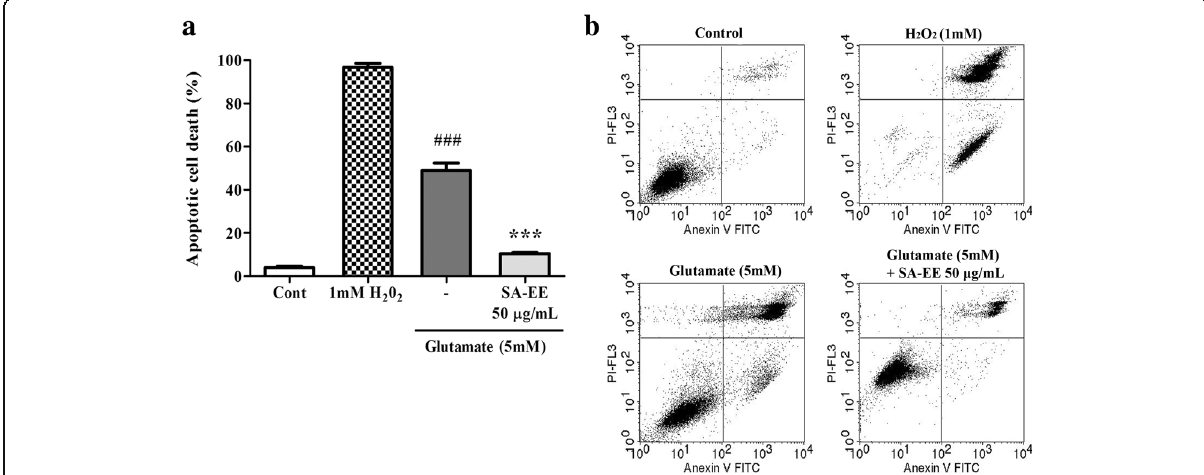
Fig. 4 Quantitative flow cytometric analysis of apoptotic cells in HT22 cells. HT22 cells were exposed to 5 mM glutamate alone or glutamate in combination with 50 μ g/mL SA-EE for 18 h before staining with FITC-conjugated annexin V and PI. H 2 O 2 -treated cells were used as a positive control. Percentages of apoptotic cells were detected using flow cytometric analysis of annexin V-positive/PI – negative cells (early stage, lower right quadrant) plus annexin V/PI – positive cells (late stage, upper right quadrant) ( a ). Representative scatter plots show the distribution of annexin V and PI staining for control and treated cells ( b ). All data are shown as the mean±SEM of at least three independent experiments. ### P <0.001 vs. control; ***P <0.001 vs. glutamate alone